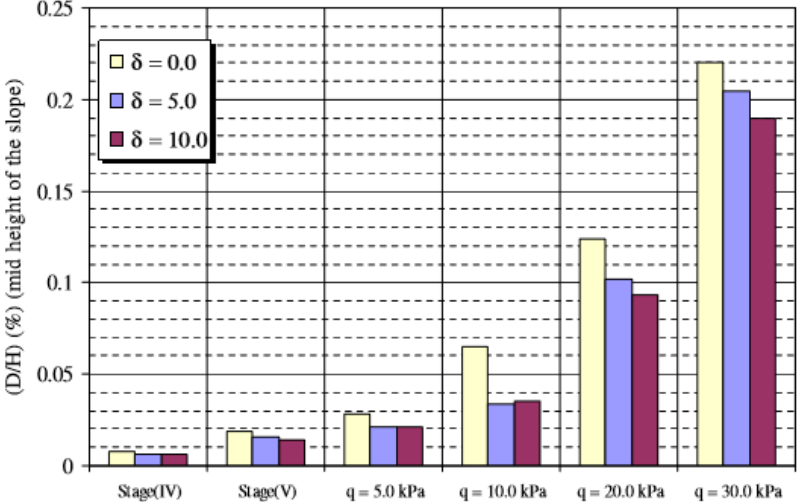
Figure 15. Influence of nail inclination on the horizontal movement at mid height of slope.